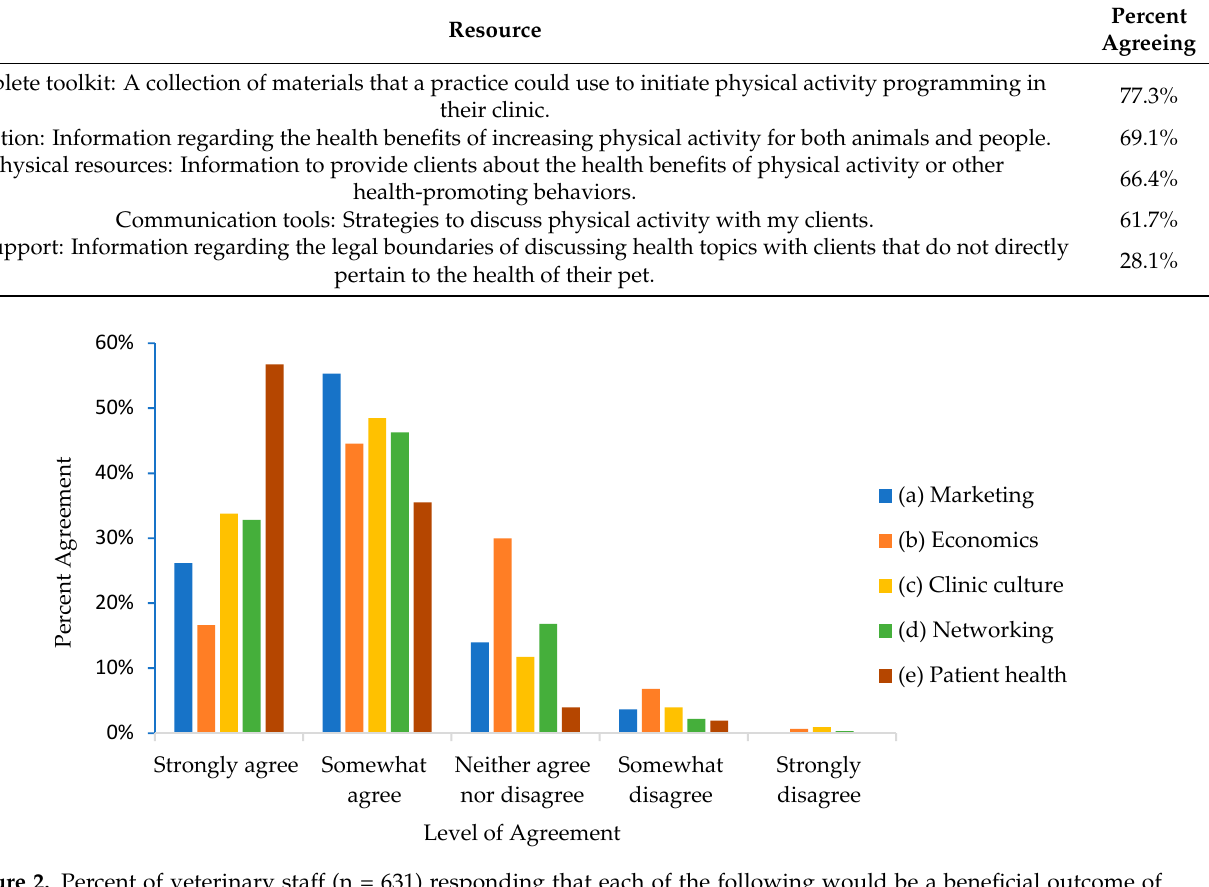
Figure 2. Percent of veterinary staff (n = 631) responding that each of the following would be a beneficial outcome of offering new and unique health programs: ( a ) promotional opportunities; ( b ) increased revenue for their practices; ( c ) would enhance clinic culture; ( d ) would provide networking opportunities; ( e ) could improve the health of clinic